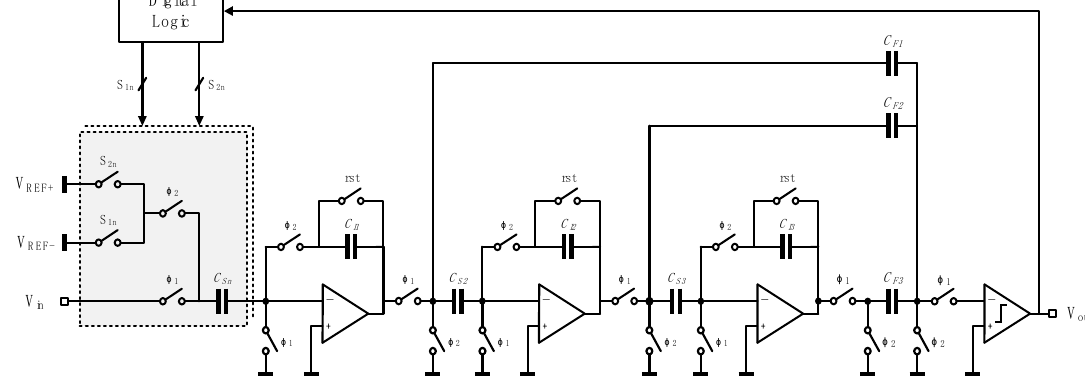
Figure 10. Simplified schematic of the analog modulator.